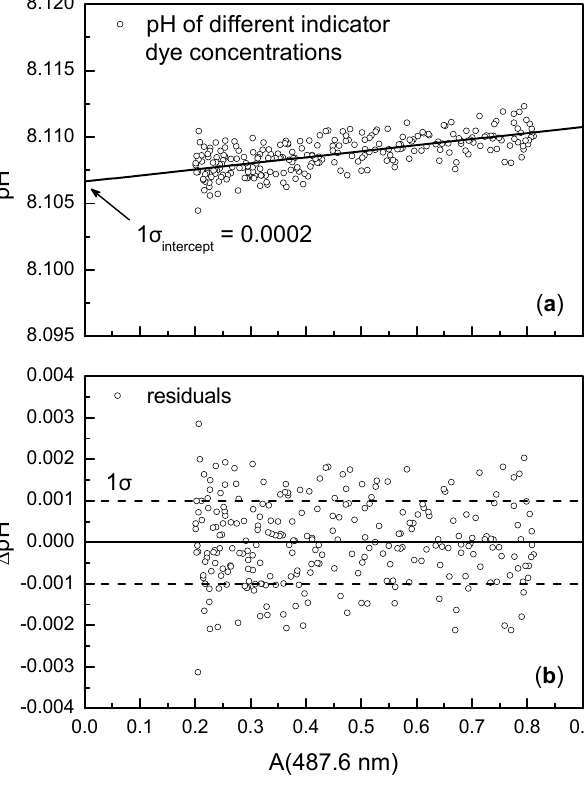
Fig. 6. Example plot for pH versus absorbance of mCP at 487.6nm. The curve in (a) represents a linear regression and extrapolation to zero indicator concentration. Slope = 0 . 0046 ± 0 . 0003; axis intercept = 8 . 1067 ± 0 . 0002; N = 258. The residuals are given in (b) . Errors are given as 1 σ standard